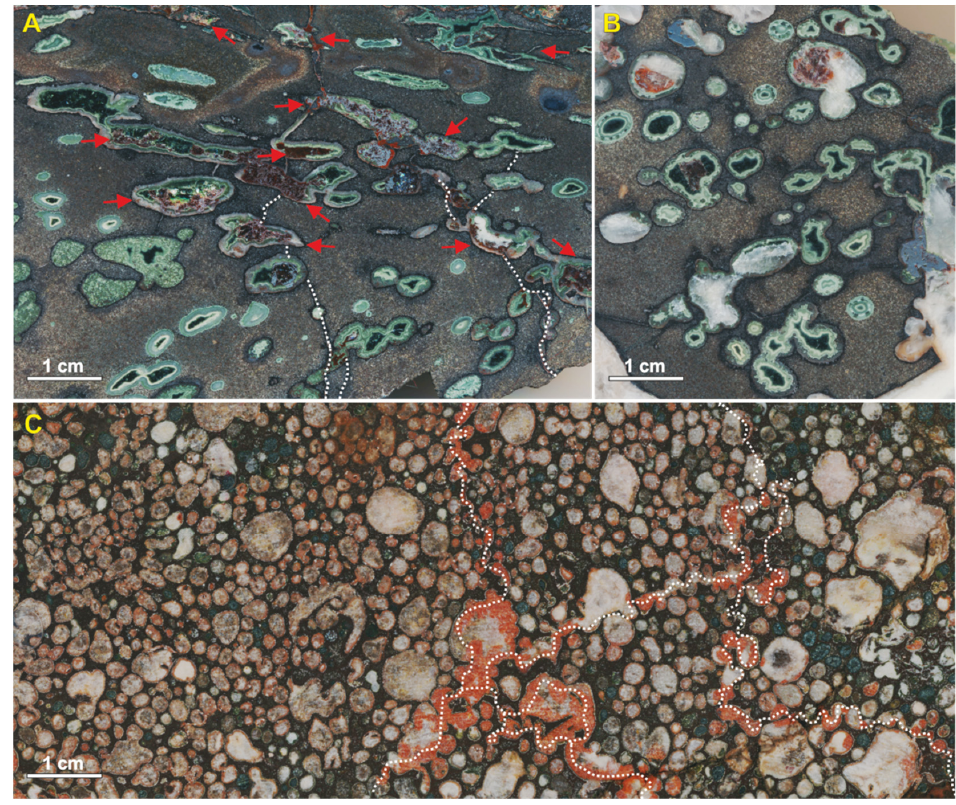
Figure 3. Photographs of the polished slabs of Mesoproterozoic vesicular basalts from the Priozersk Formation within the Pasha–Ladoga Basin. ( A , B ) Images illustrating concentrically zoned amygdales tend to be filled with chlorite. Red arrows point to deformed amygdales and fissures with iron oxides appearance. ( C ) Image showing dense accumulation of rounded and irregularly formed amygdales with red-brownish pigments. Dotted lines point to channels of Fe-bearing solution supply.